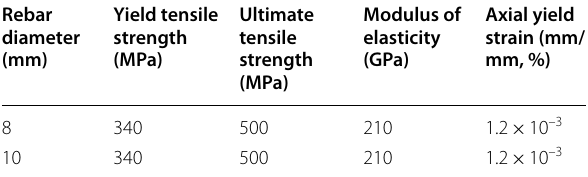
Table 1 Concrete mix design and compressive strength of specimens.